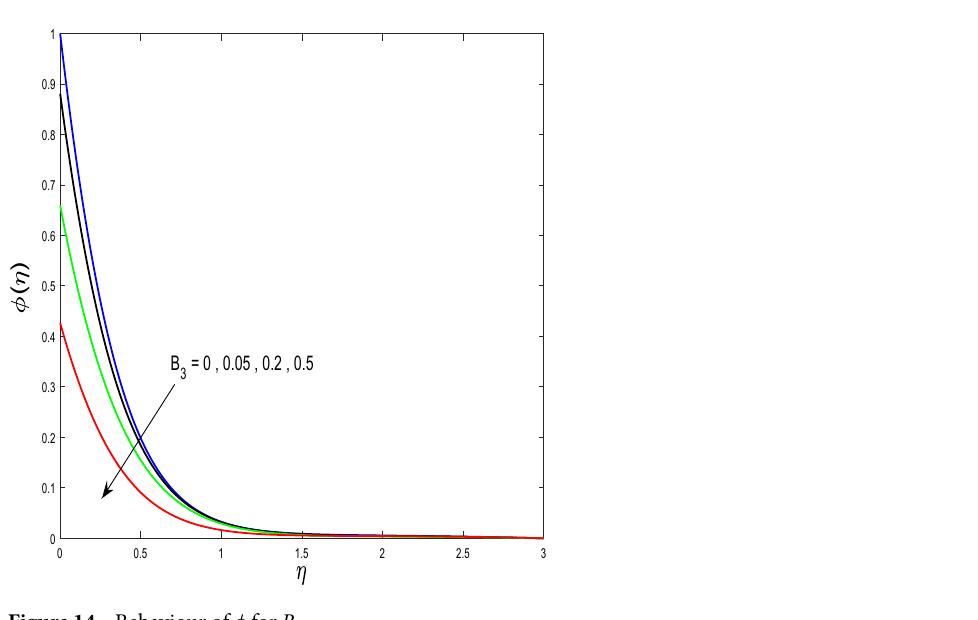
Figure 14. Behaviour of φ for B 3